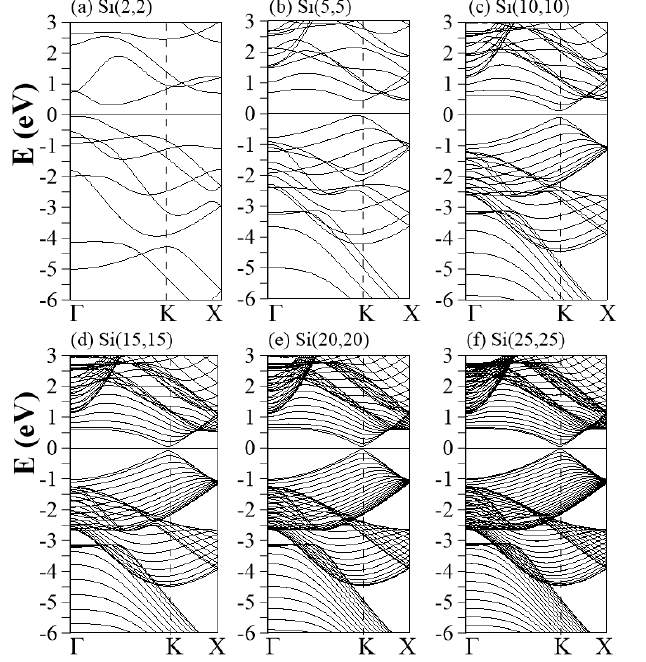
Figure 2. Band structures of aSiNTs with different chiral vectors: ( a ) (2,2), ( b ) (5,5), ( c ) (10,10),